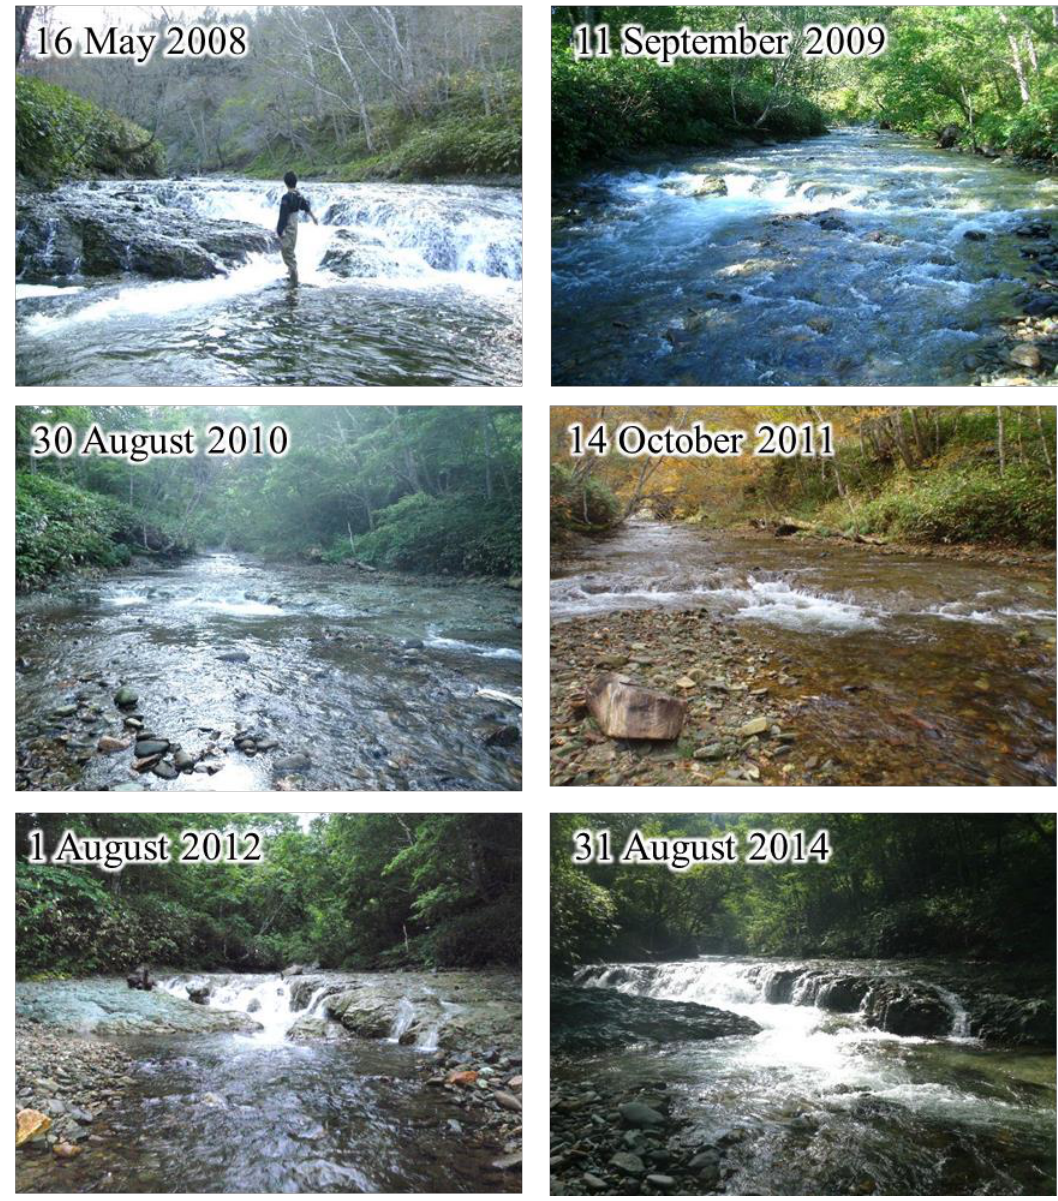
Figure A2. A small step in the downstream section (D1) of the check dam before (16 May 2008) and after (11 September 2009–31 August 2014) dam removal (February 2009). The small step was buried during the first sediment evacuation from the dam and remained to be buried on 14 October 2011. However, on 1 August 2012, the step was exposed to the pre-dam-removal level. This indicates that the sediments buried the step moved downstream during the 10 months between these observations.